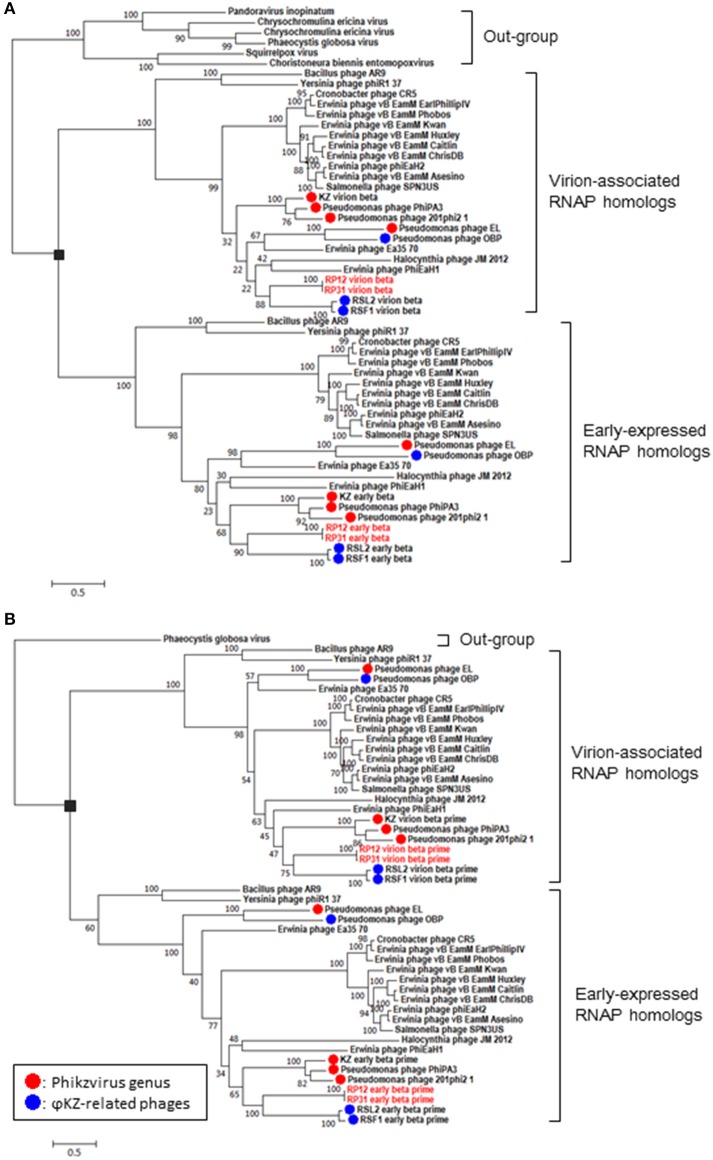
Phylogenetic relationships of virion-associated and early-expressed RNAP homologs. Maximum likelihood phylogenetic trees of RNA polymerase β subunits (A) and β′ subunits (B). ORFs corresponding to each subunit were concatenated before building sequence alignments. Black rectangles correspond to proposed gene duplications. Bootstrap values are given along the branches. Number at scale bar indicates the number of substitutions per site.